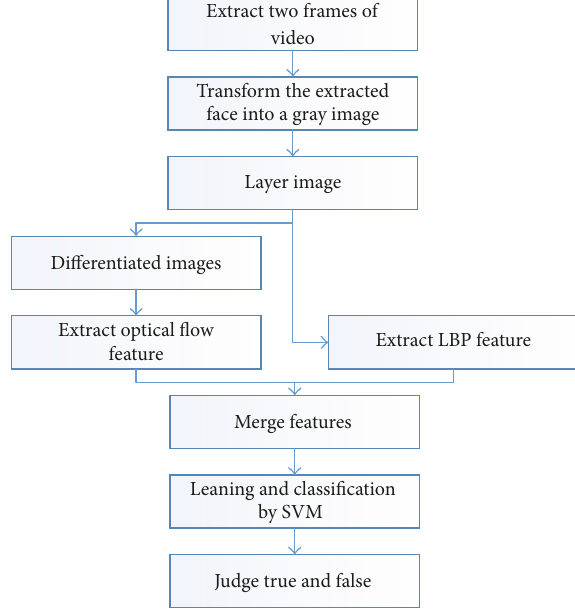
Figure 7: Algorithm